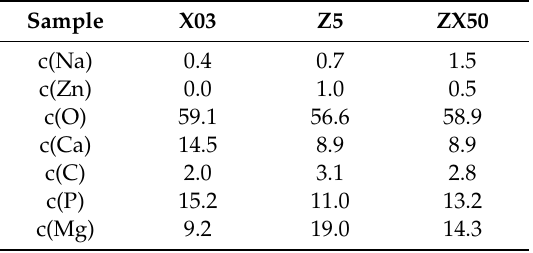
Table 4. Elemental concentrations in at% for elements detected at the top of the degradation layer in all measured